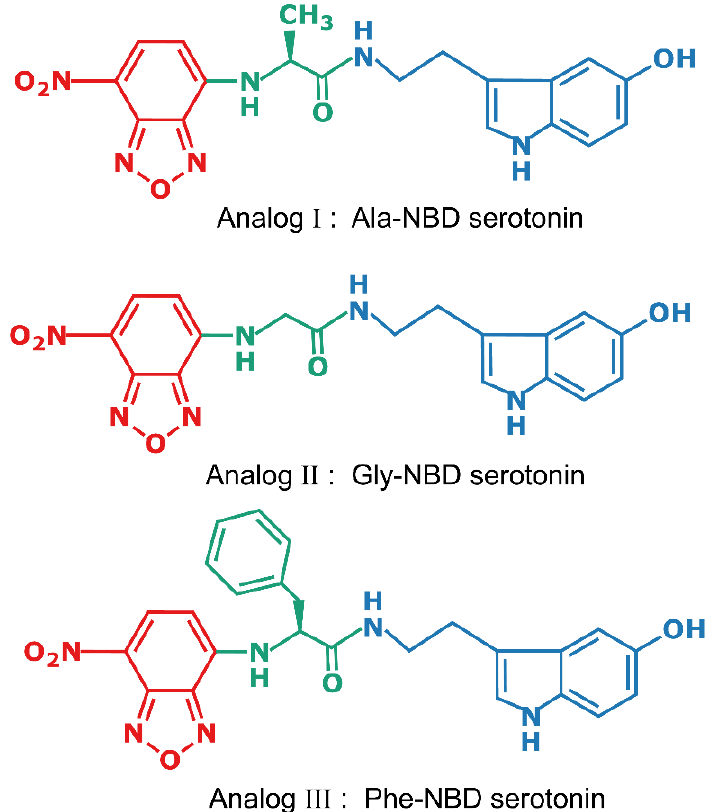
Figure 1. Chemical structures of the fluorescent NBD-labeled analogs of serotonin used in this study. The fluorophore (NBD) is shown in red, serotonin is shown is blue, and the linker amino acid is depicted in green.